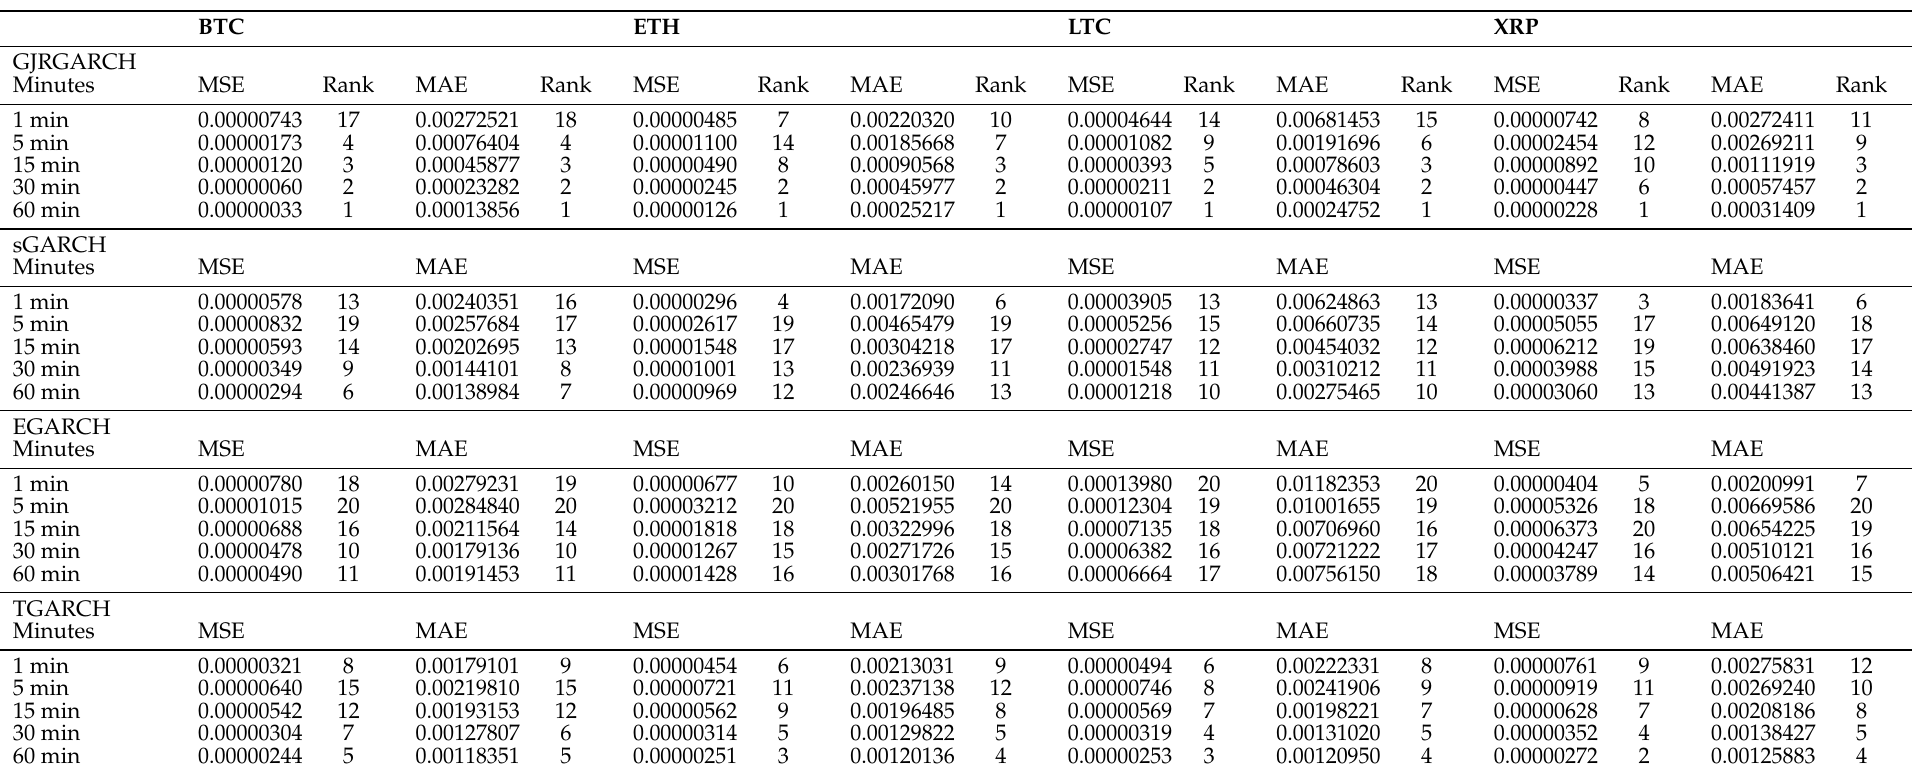
Table 6. Out-of-sample evaluation of the volatility